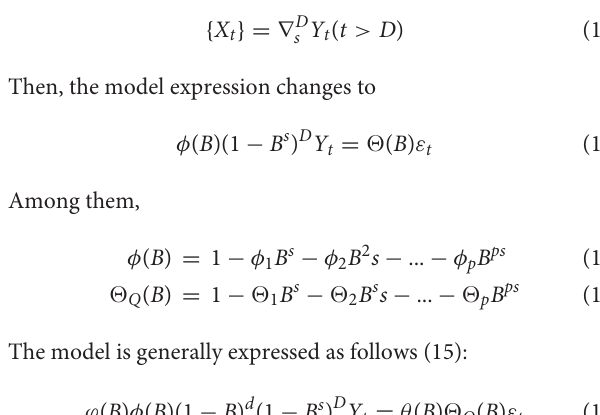
FIGURE 1 | Structure of a simple neuron.